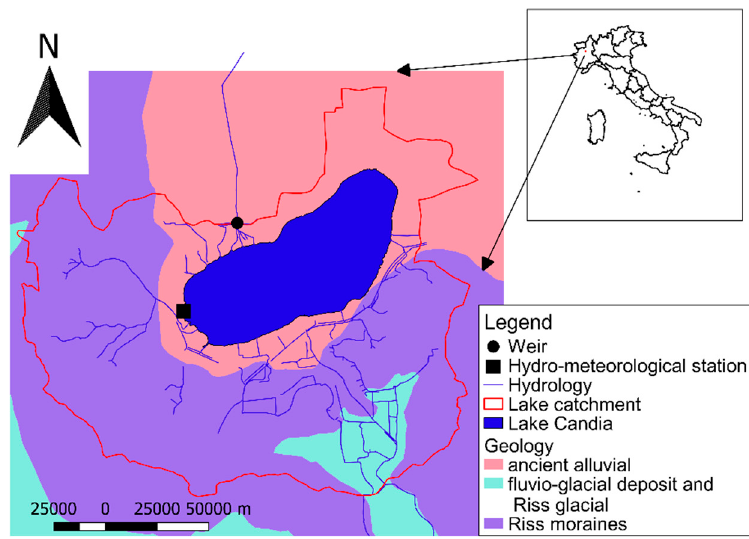
Figure 1. Catchment of Lake Candia.